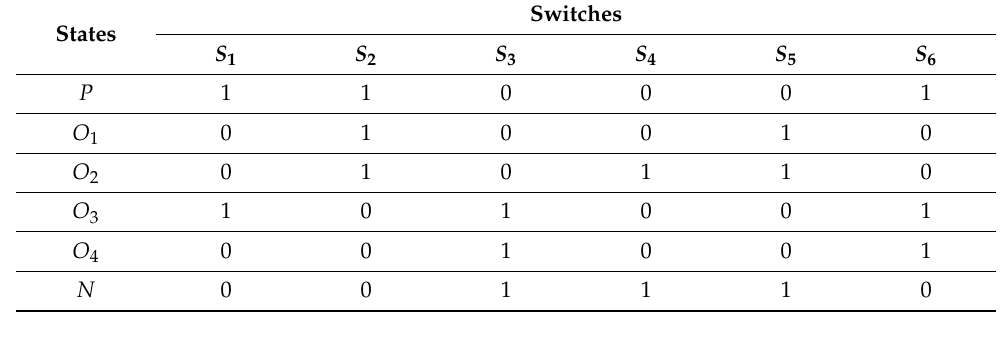
Table 3. Switching states for the proposed HANPC inverter. Figure 3. Schematic diagram of the hybrid ANPC inverter comprising UWBG switches.